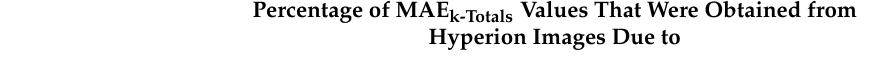
Table 5. The percentage of MAE k-Totals values due to Hyperion sensor characteristics added to the error in the simulation of real data and the percentage of MAE k-Totals values due to errors in co-localization and spatial resampling of the image.